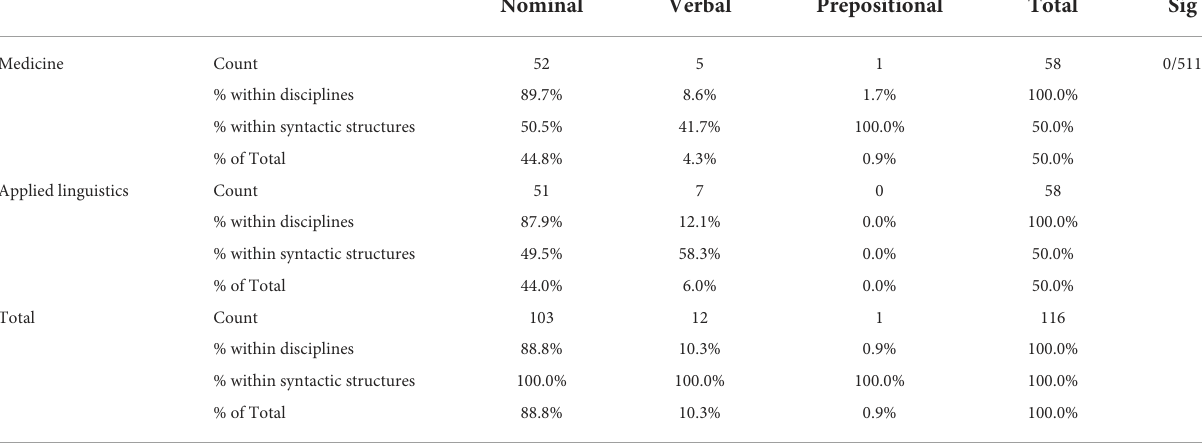
TABLE 4 Frequency and percentage of title components or syntactic structures in single-unit titles in the two disciplines (chi-square test). Nominal